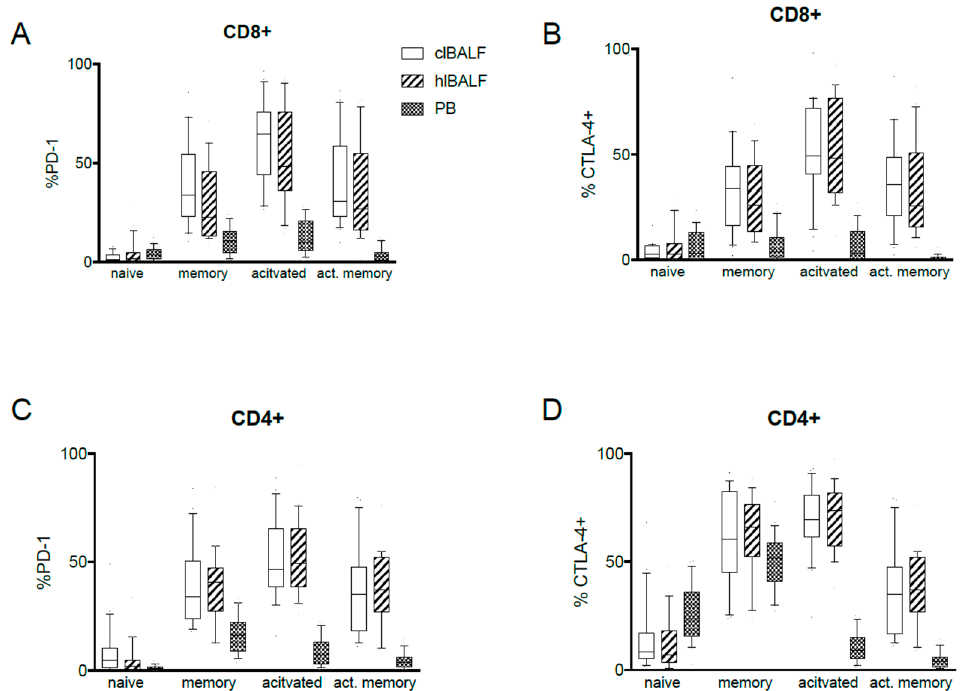
Figure 2. PD-1 and CTLA-4 expression by T cell subsets in different compartments. Differences between the proportions of naïve (n), memory (m), activated (a), and activated memory (am): ( A ) CD8+ PD-1-positive cells; ( B ) CD8+ CTLA-4-positive cells; ( C ) CD4+PD-1-positive cells; and ( D ) CD4+CTLA-4-positive cells in the clBALF, hlBALF and PB.